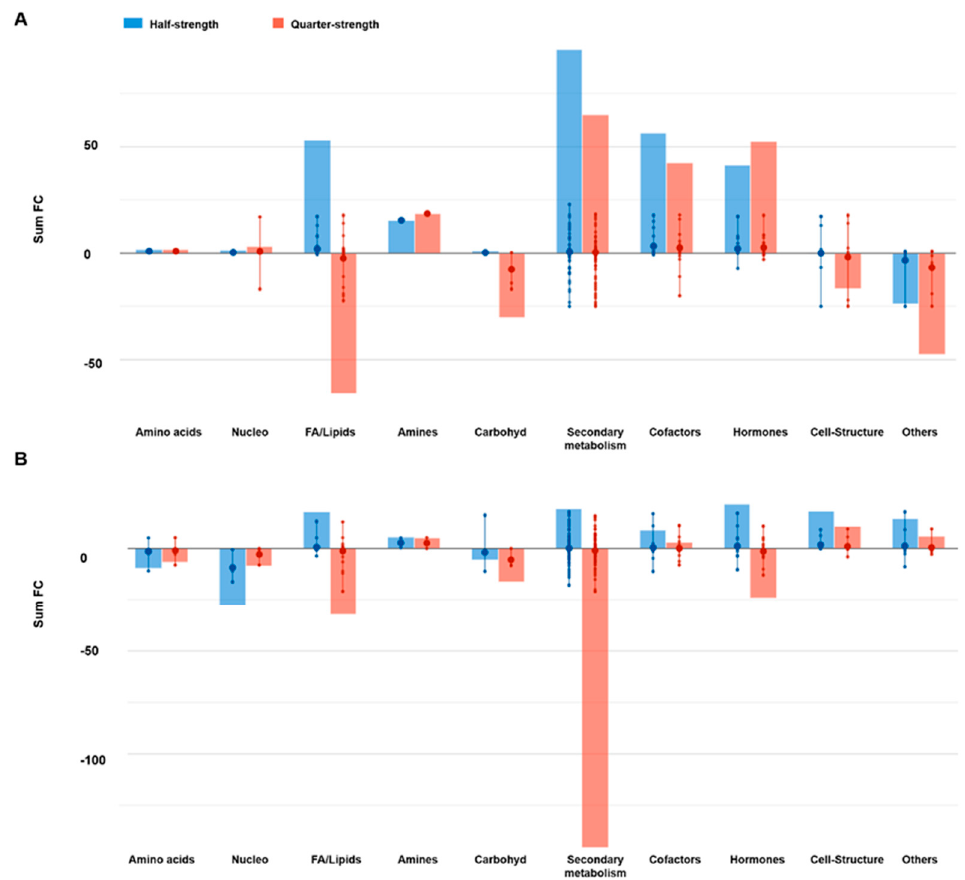
Figure 2. Processes affected by the macrocation concentration in ‘Red’ ( A ) and ‘Green Salanova’ ( B ). Differential metabolites and their fold-change (FC) values were elaborated using the Omic Viewer Dashboard of the PlantCyc pathway Tool software (www.pmn.plantcyc.com). In each class, the large dot represents the average (mean) logFC of the metabolites. Small dots represent the individual logFC for each metabolite. The abbreviated subcategory names on the x -axis correspond to: Nucleo: nucleosides and nucleotides; FA/Lipids: fatty acids and lipids; Amines: amines and polyamines; Carbohyd: carbohydrates; Cofactors: cofactors, prosthetic groups, electron carriers, and vitamins.